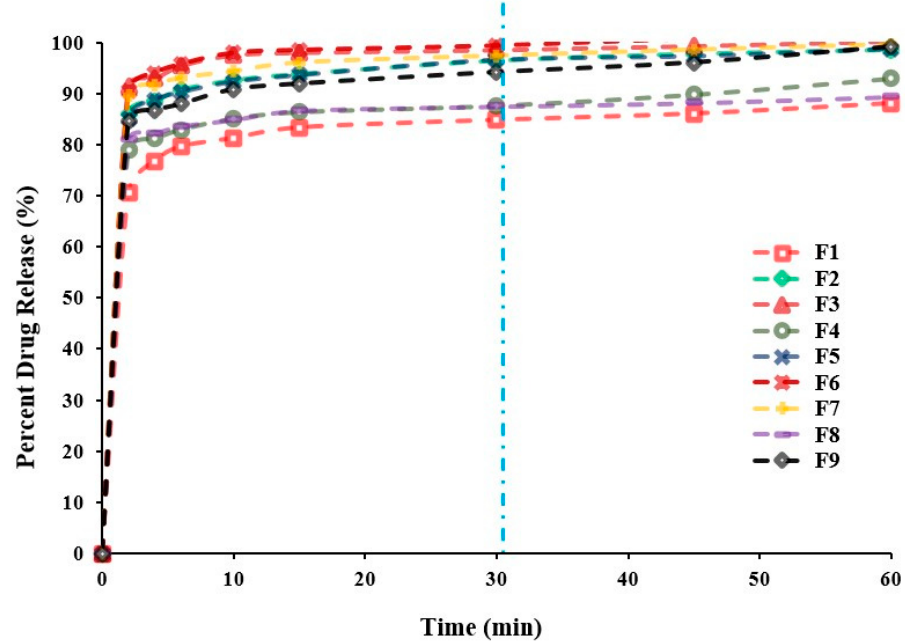
Figure 3. In vitro SUL release profiles from SUL-FDTs based on 3 2 Full Factorial Design. Because of overlapping, error bars are omitted for clarity.